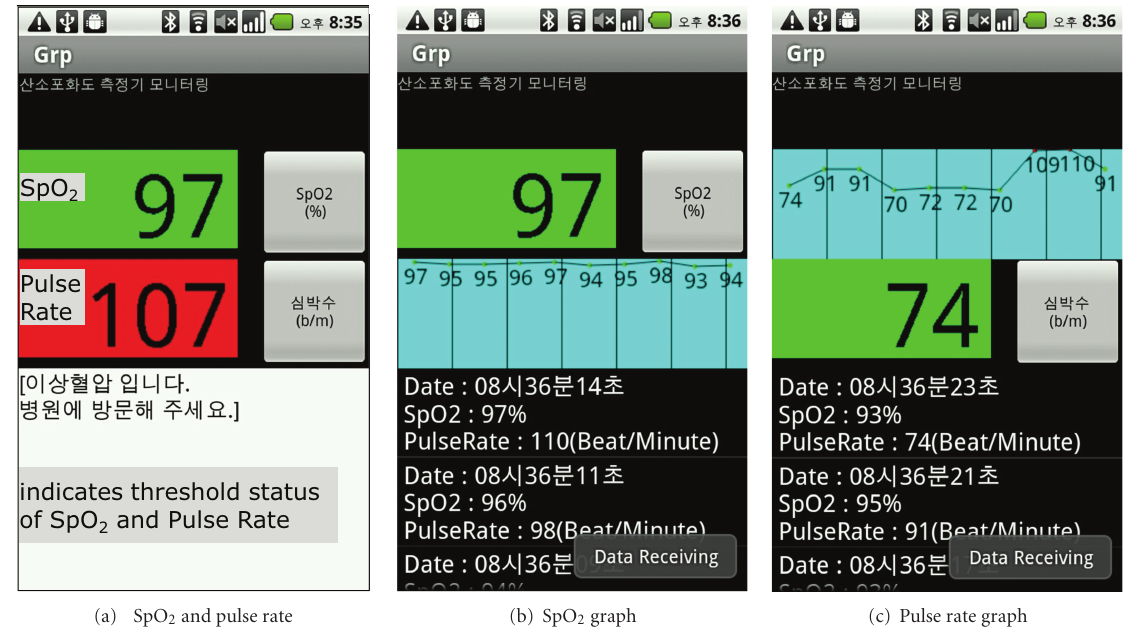
Figure 8: Screenshots of PHD manager.